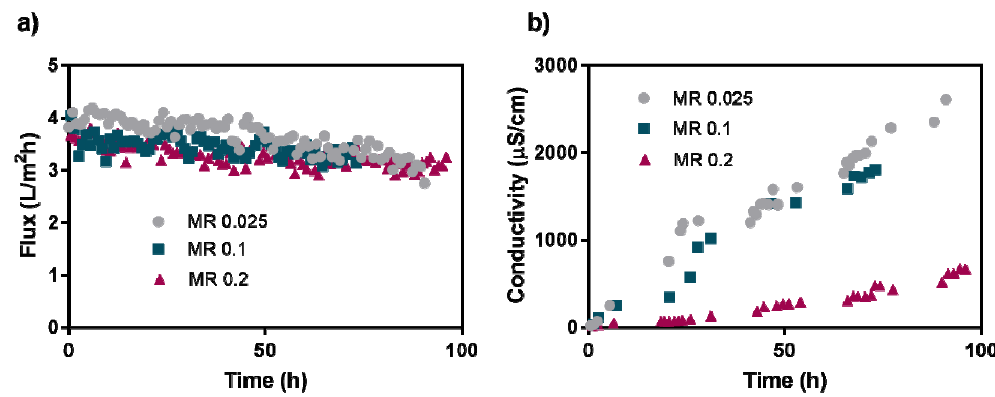
Figure 2. ( a ) Flux and ( b ) permeate conductivity profile of composite PVA/PVDF membrane with different molar ratio of glutaraldehyde to PVA repeat unit (MR 0.025, 0.1, 0.2) using a feed solution of 100 g/L NaCl at 65 °C.